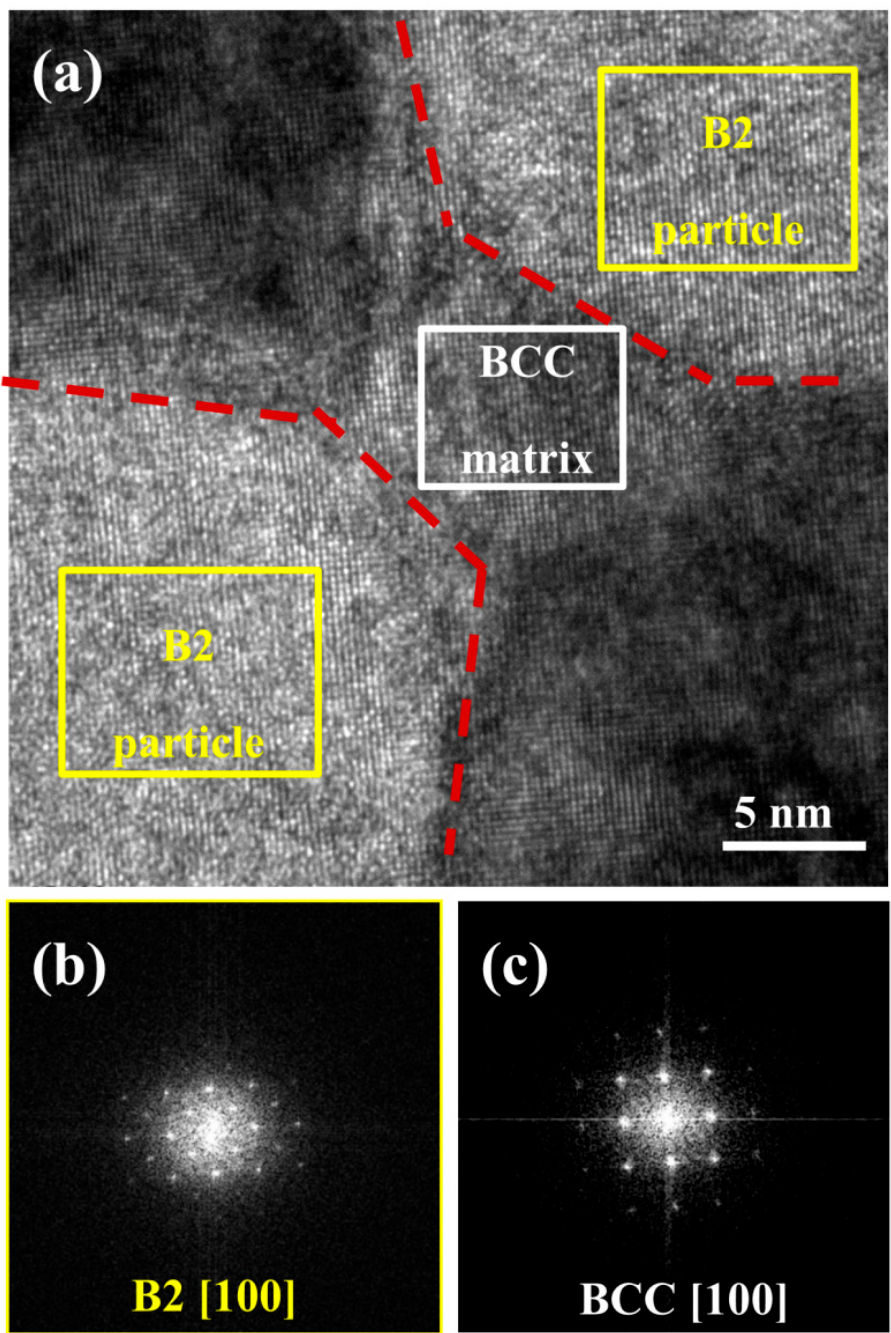
Figure 4. HRTEM images of S3 RHEA at 873K-aged state along the [100] BCC zone axis. ( a ): the HRTEM image showing the interfaces between the BCC matrix and cuboidal B2 nanoprecipitate; ( b , c ): the FFT patterns of B2 and BCC matrix nanoprecipitates, respectively.